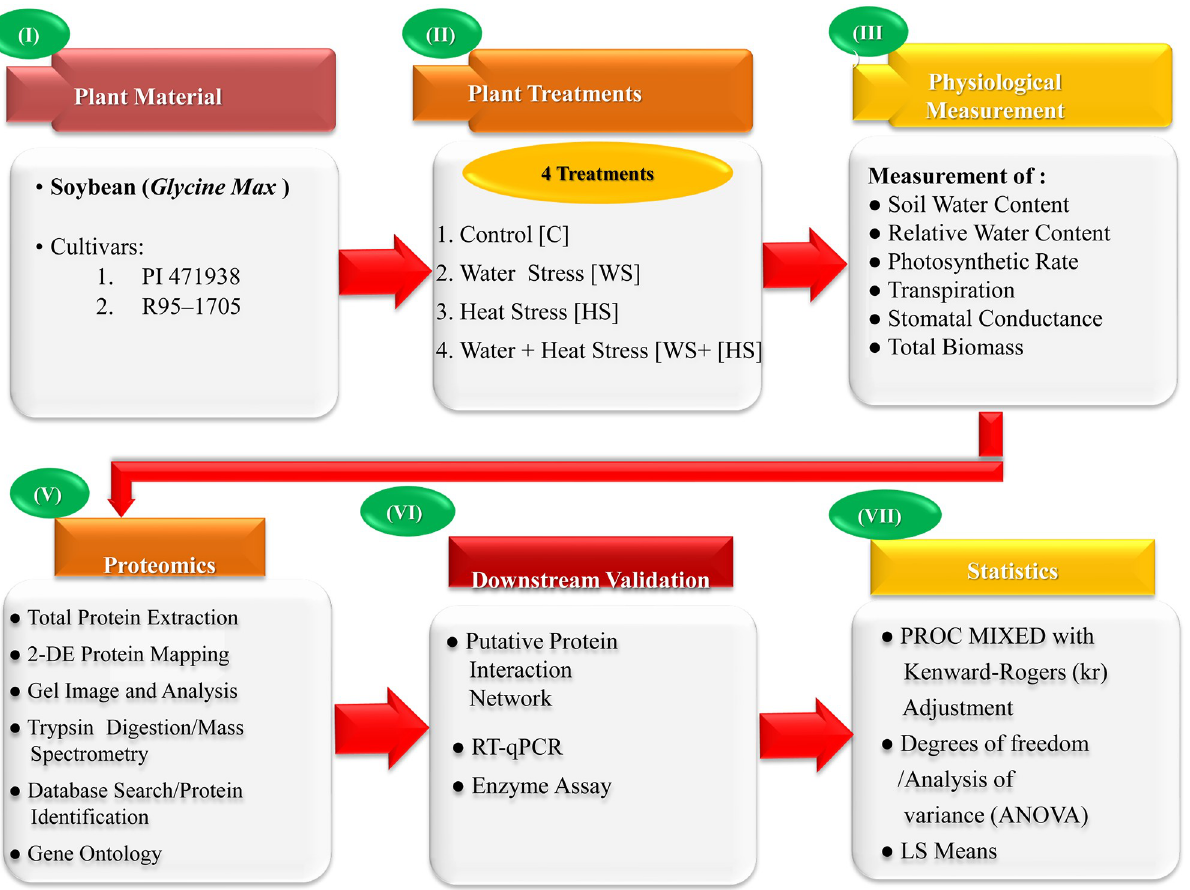
Fig 1. Experimental outline, deciphering the analysis of physiological and biochemical changes in response to stress in soybean.